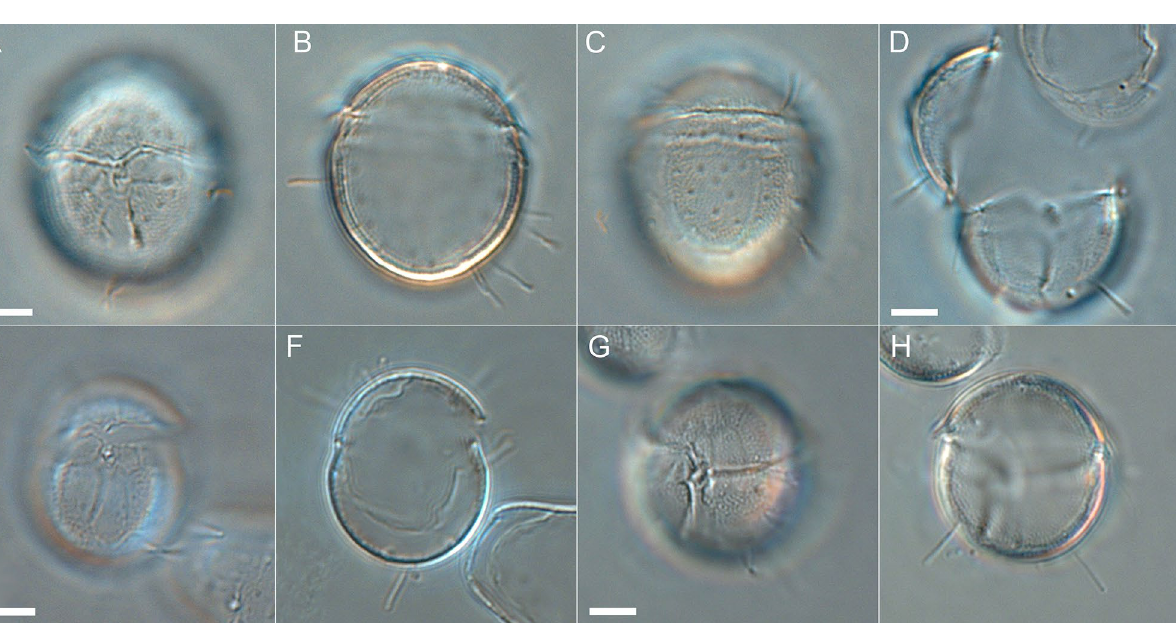
Figure 7. Light microscopy images of Fensomea setacea , gen. & sp. nov. (GeoB*184), that illustrate the echinate through baculate ornamentation and the slender processes. ( A – C ) Different focal planes of a cell in ventral ( A ), median ( B ) or dorsal view ( C ). ( D ) Cell in ventral view; note that the epitheca has broken up. ( E , F ) Two different focal planes of a cell in dorsal view. ( G , H ) Two focal planes of a cell in ventral-lateral view. Scale bars = 5